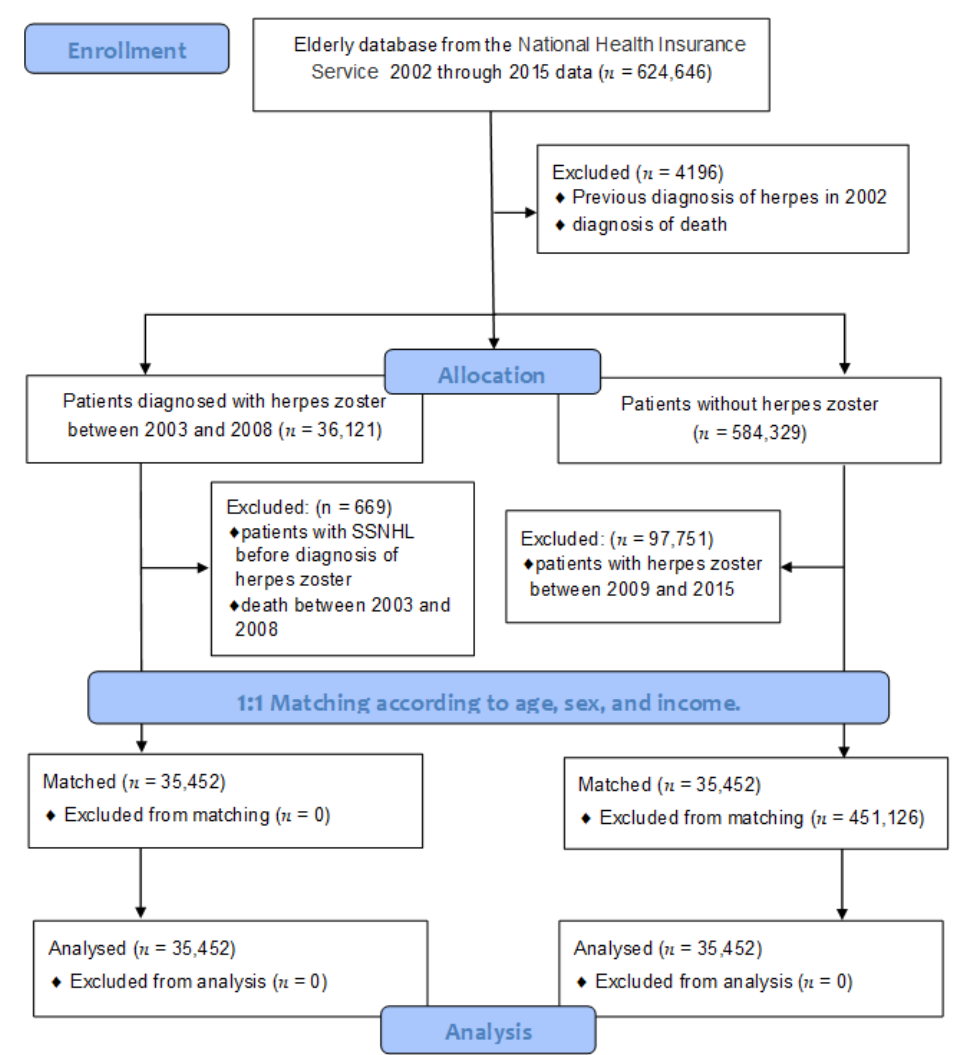
Figure 1. Flow diagram of the patient selection process in this study .